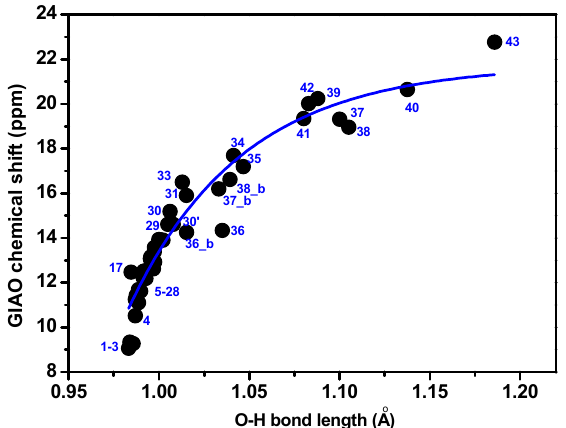
Figure 14. Calculated, at the GIAO/B3LYP/6-311+G(2d,p) level of theory with CPCM in CHCl 3, OH proton chemical shifts vs. calculated elongation of the O–H bond, Å, of the structures of the compounds of Figure 9 optimized at the M06-2X/6-31+G(d) level of theory. The notation b refers to the bent complex (see text and Table 1). Adopted, with permission, from [47]. Copyright 2015, The Royal Society of Chemistry.